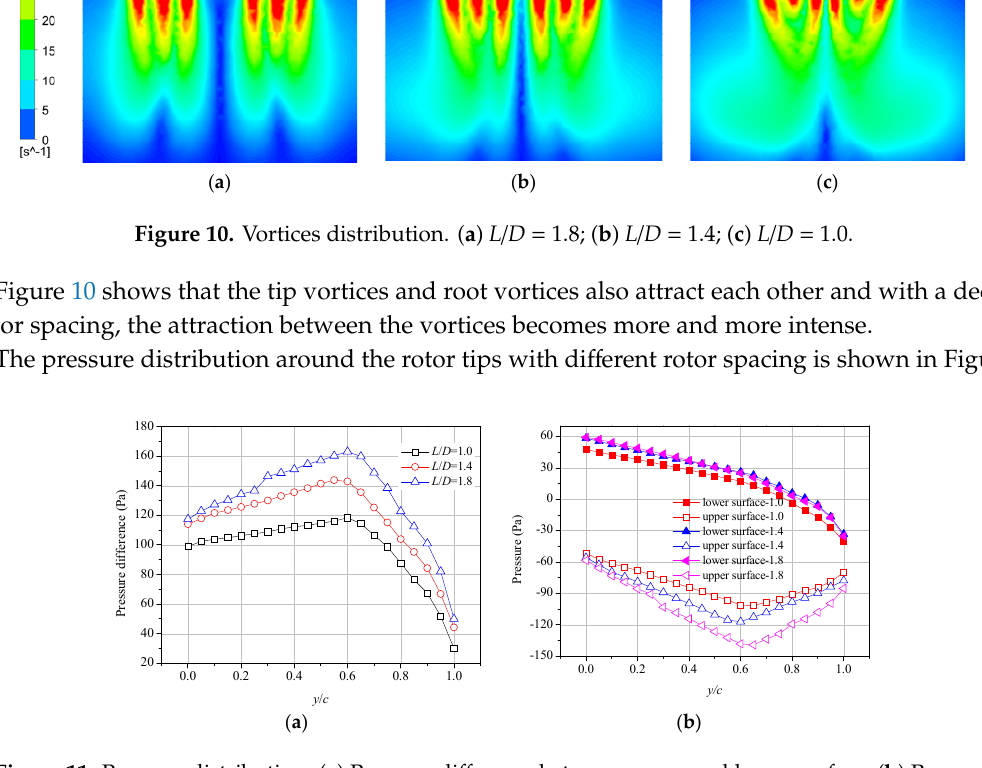
Figure 11. Pressure distribution. ( a ) Pressure difference between upper and lower surface; ( b ) Pressure distribution of upper and lower surface.